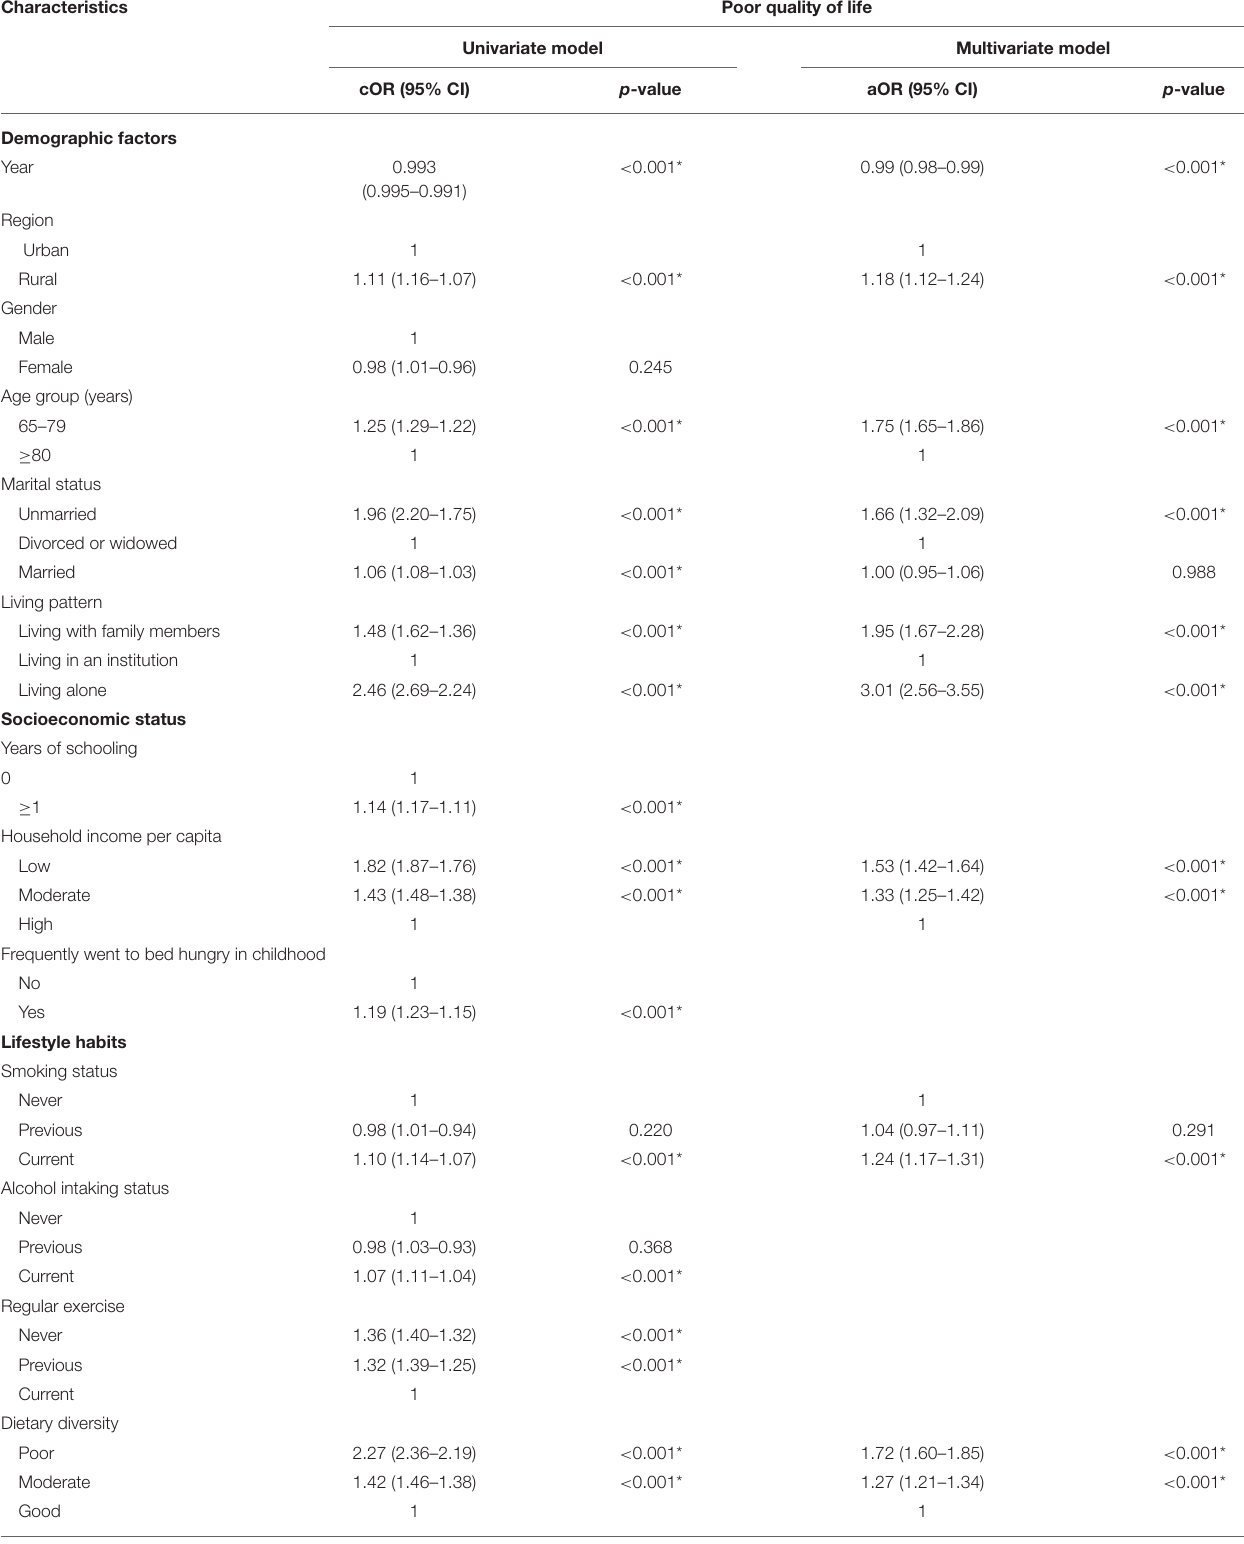
TABLE 2 | Factors related with poor quality of life in the logistic regression models ( N =